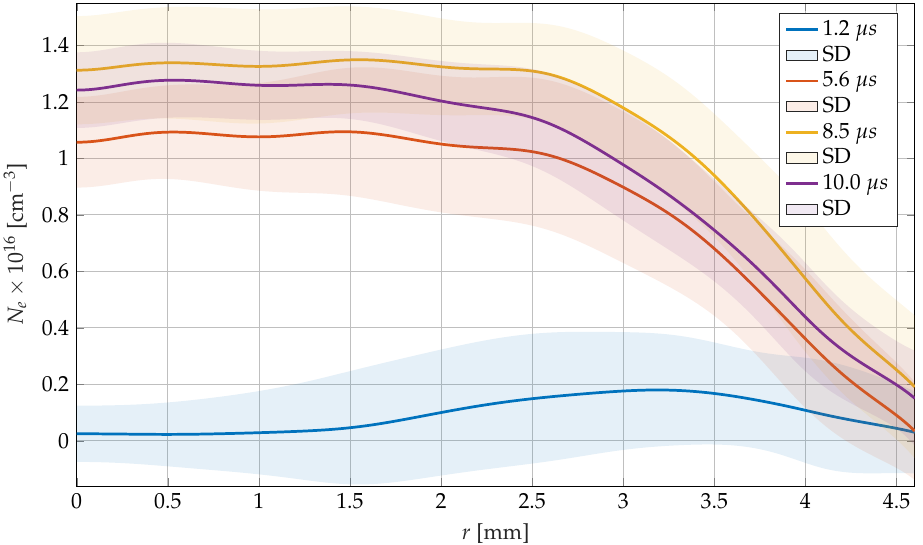
Figure 4. Radial profiles of electron density averaged along Z axis measured for various time delays at filling pressure of